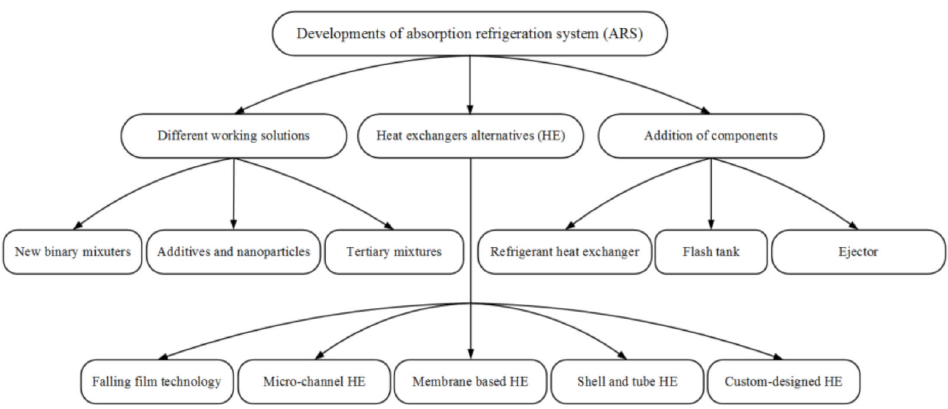
Figure 1. Common ways for developing an absorption refrigeration